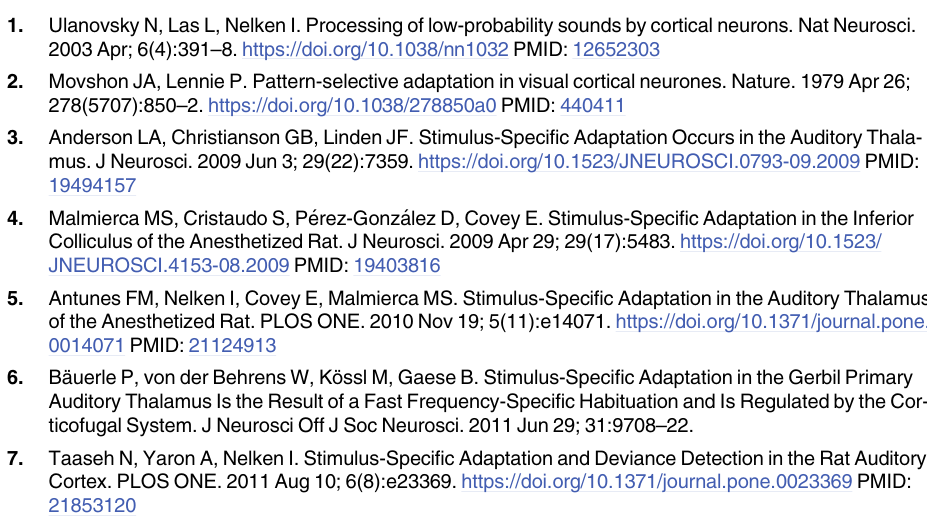
between the two stimuli. c. Spectrograms of the two stimuli. The ladder-like structures are the harmonics of the pitch of the two vowels, set to 300 Hz. S2 Fig. Detection of freezing. The algorithm used the video movie of the test episode. Starting from the individual frames (a), pairwise differences between successive frames were computed (b). The number of non-zero pixels was counted and smoothed. Panel c (blue) shows an exam- ple of such a smoothed trace. Freezing periods were determined by thresholding this trace (red line). Panel c (black) shows the resulting decisions. The fraction of time that freezing episodes occupied was determined separately for a baseline period (gray rectangle), for presentations of the CS+ (red) and for presentations of the CS- (green), as shown in panel d. (PDF) S1 File. The data underlying the paper. The file plotPaperData.zip contains a data file, plotPa- perData.mat (matlab .mat file), that includes all data used in the paper. It also includes a matlab script, allfigures.m, that generates all the figures from the